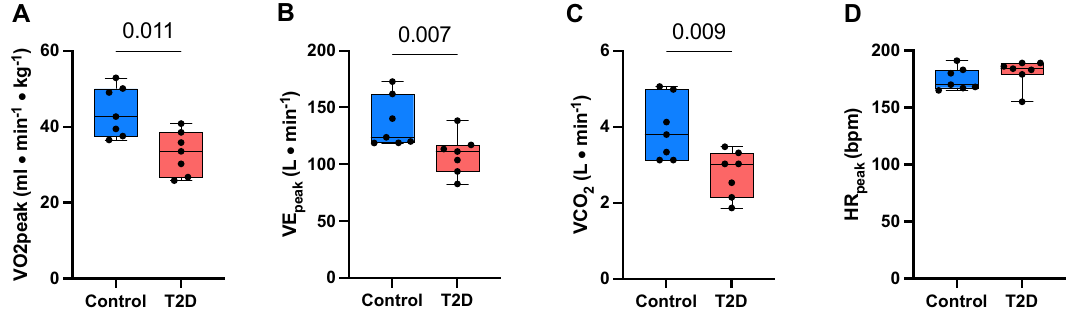
Figure 1. Baseline data from cardiopulmonary exercise tests between the controls and type 2 diabetes (T2D) group. ( A ) Peak oxygen uptake (VO 2peak ) displayed in ml min –1 kg –1 ; ( B ) minute ventilation peak (VE peak ) displayed in L min −1 ; ( C ) ventilatory CO 2 per minute (VCO 2 ) displayed in L min −1 ; ( D ) peak heart rate (HR peak ) displayed in beats per min (bpm). Data presented with box and whiskers with minimum to maximum values. p values are indicated in figure. Control: n = 7, T2D: n = 7.